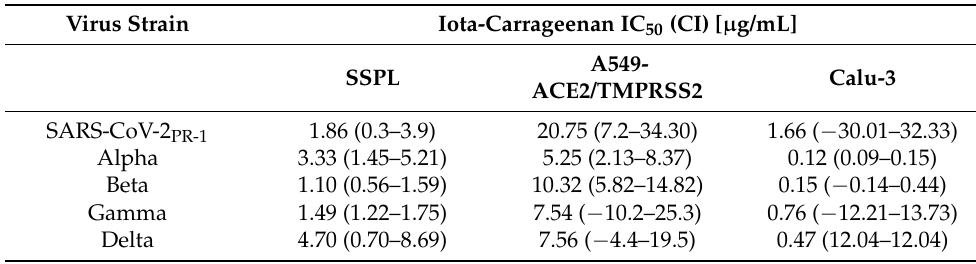
Table 1. IC 50 of Iota-carrageenan against SARS-CoV-2 wt and its VOCs in a SSPL system, A549- ACE2/TMPRSS2 cells and Calu-3 cells. The 95% confidence interval (CI) is given in